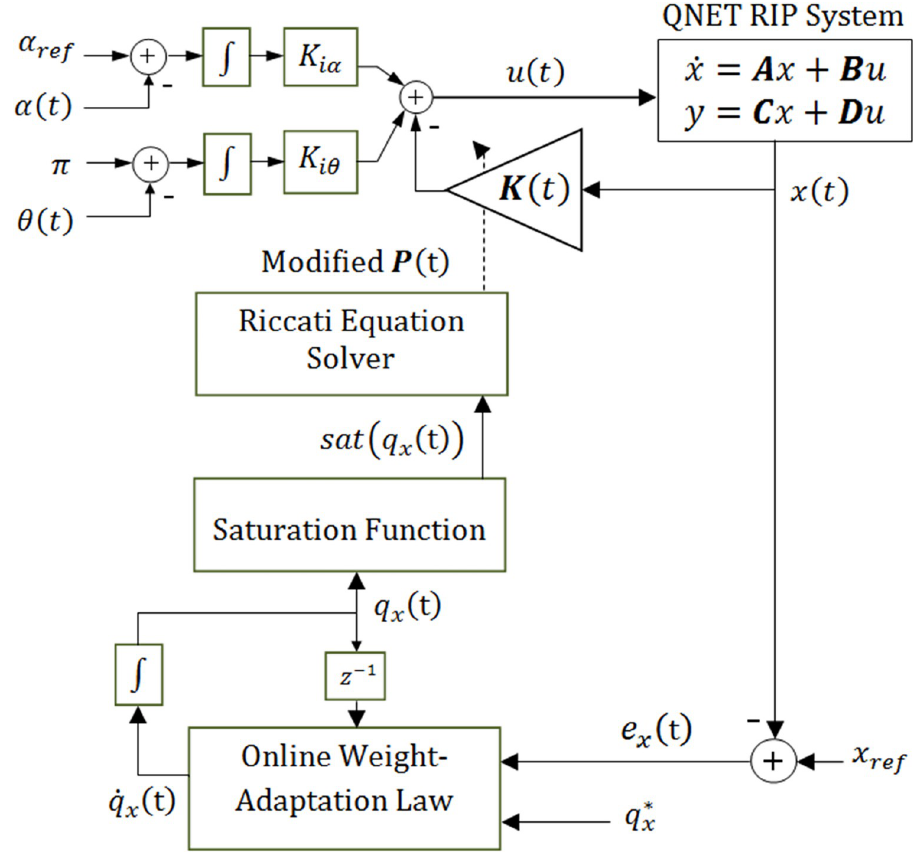
Fig 4. The improved variable–structure LQIC